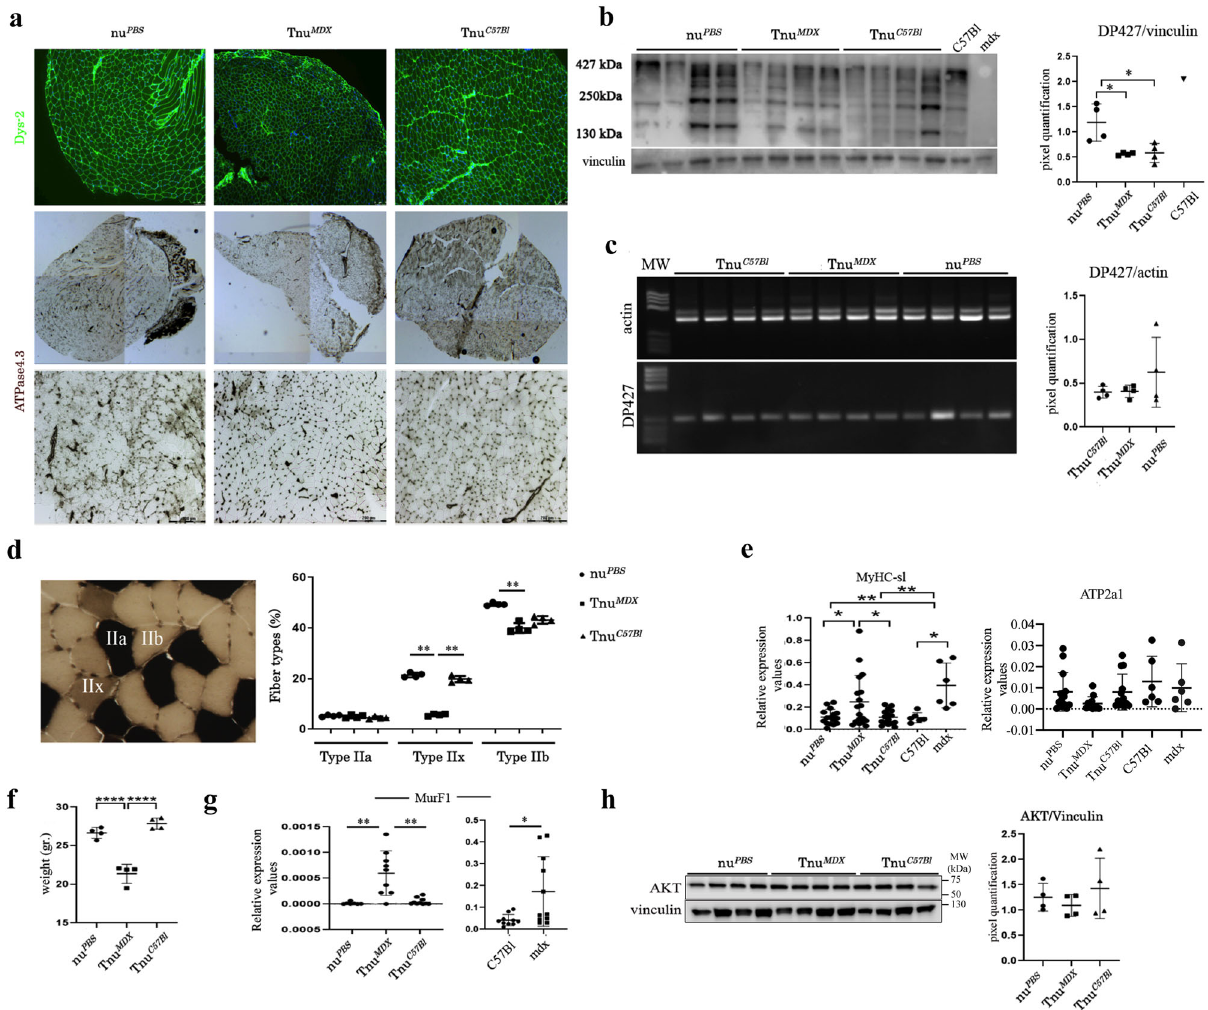
Fig. 6 Adult dystrophic thymus transplantation determines dystrophic muscle features and skeletal muscle regression. Representative immune fl uorescence staining with DYS-2 (C-terminal-domain) antibody. Overall, confocal microscope images of TAs from nu PBS , Tnu MDX and Tnu C57Bl showed weak dystrophin intensity around the myo fi bers in TA of Tnu MDX mice ( a ). Overview and higher magni fi cation of ATPase (pH 4.3) muscle sections of TAs from nu PBS , Tnu MDX and Tnu C57Bl mice ( a ). Densitometric analysis of WB images of dystrophin protein expression showed downregulation of Dp427 dystrophin isoform in TA muscles of Tnu MDX and Tnu C57Bl mice ( b ). RT-PCR analysis of TA of nu PBS , Tnu MDX and Tnu C57Bl mice determined the expression of Dp427 dystrophin isoform ( c ). Representative images of skeletal muscle showed the distribution and composition of the myosin heavy chain (MyHC) isoforms (Type IIa, Type IIx and Type IIb). Graph portrays the percentage of myo fi bers expressing different MyHC isoforms in TAs of nu PBS , Tnu MDX and Tnu C57Bl mice. n = 10 images were analysed for each mouse ( d ). RT-qPCR experiments on TA muscles demonstrated the over-expression of